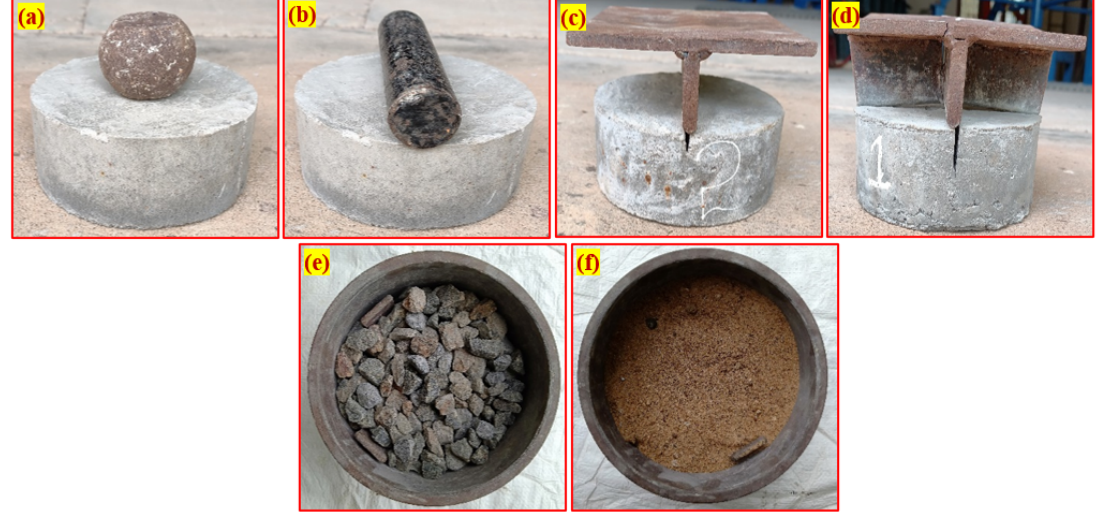
Figure 3. Modifications to the ACI test method: ( a ) ACI method. ( b ) Line impact load transfer by steel bar. ( c ) Line notch specimen with load transfer plate. ( d ) Cross-notch specimen with load transfer plate. ( e ) Coarse aggregate bedding. ( f ) Sand bedding.